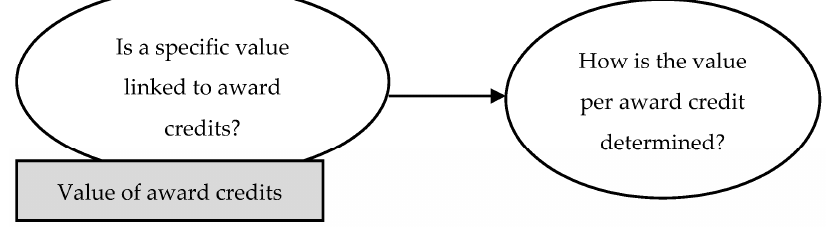
Figure 10. Determining value linked to award credits.